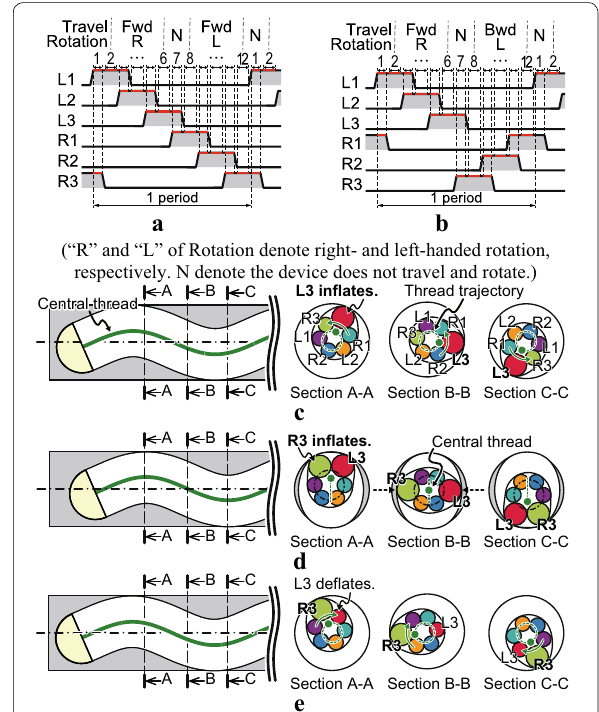
Fig. 3 Motion of six braided-tube device utilizes both groups of tubes. a and b Pressurizing patterns which generate only propulsion and rotation, respectively. With a pattern, the device travels in same direction and rotate in both directions, the propulsion exists while the rotations are canceled out. On the other hand, the rotation exists while the propulsion are canceled out with b pattern. c , d , and e The deformations when a tube of Group L (L3), one tube in each group (L3&R3), and a tube of Group R (R3) inflate, respectively. The device deforms into a left-handed helix, a planar wave, and a